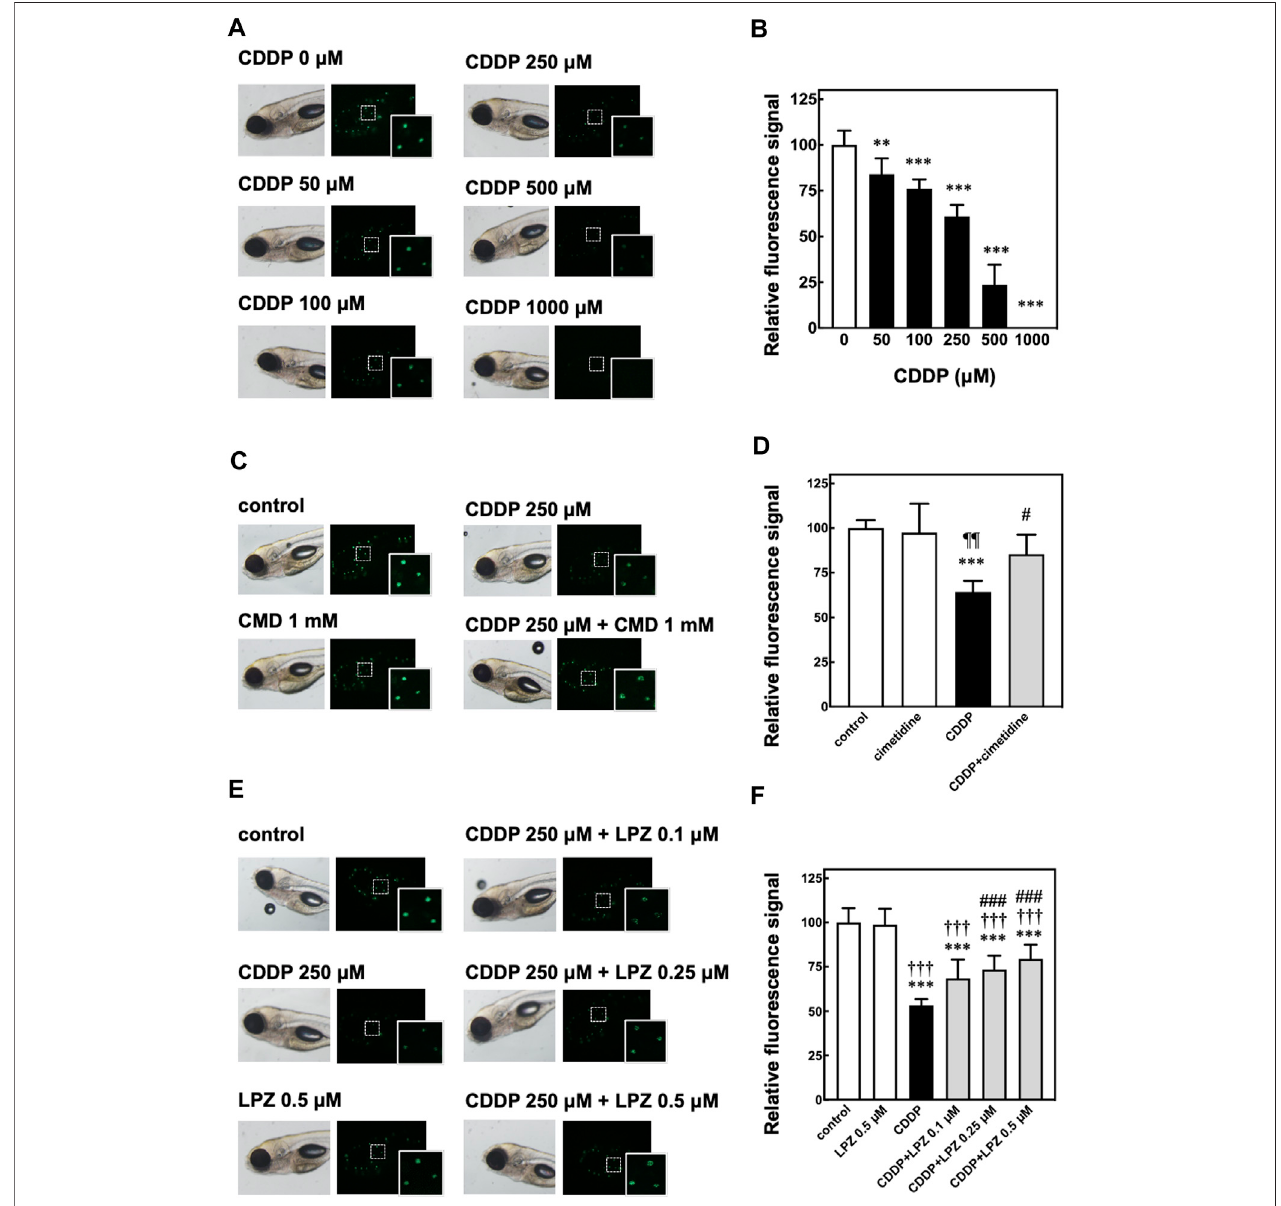
FIGURE 1 | In vivo fl uorescence imaging of hair cells in zebra fi sh to assess CDDP-induced ototoxicity and otoprotective effects of cimetidine and lansoprazole. (A,B) Zebra fi shweretreatedwithCDDPatindicateddosesfor2 h,followedbystainingwithYo-Pro-1ofsensoryhaircells.The fl uorescencesignalsofthreeneuromasts including hair cells shown in the white rectangles were calculated and are shown as the percentage of the signal in zebra fi sh without CDDP treatment. (C – F) Zebra fi sh were treated with or without cimetidine (CMD, (C,D) or lansoprazole (LPZ, (E,F) to examine their effect on the decrease of fl uorescence signals in hair cells in zebra fi sh exposed to CDDP. Quantitative analyses were performed as described